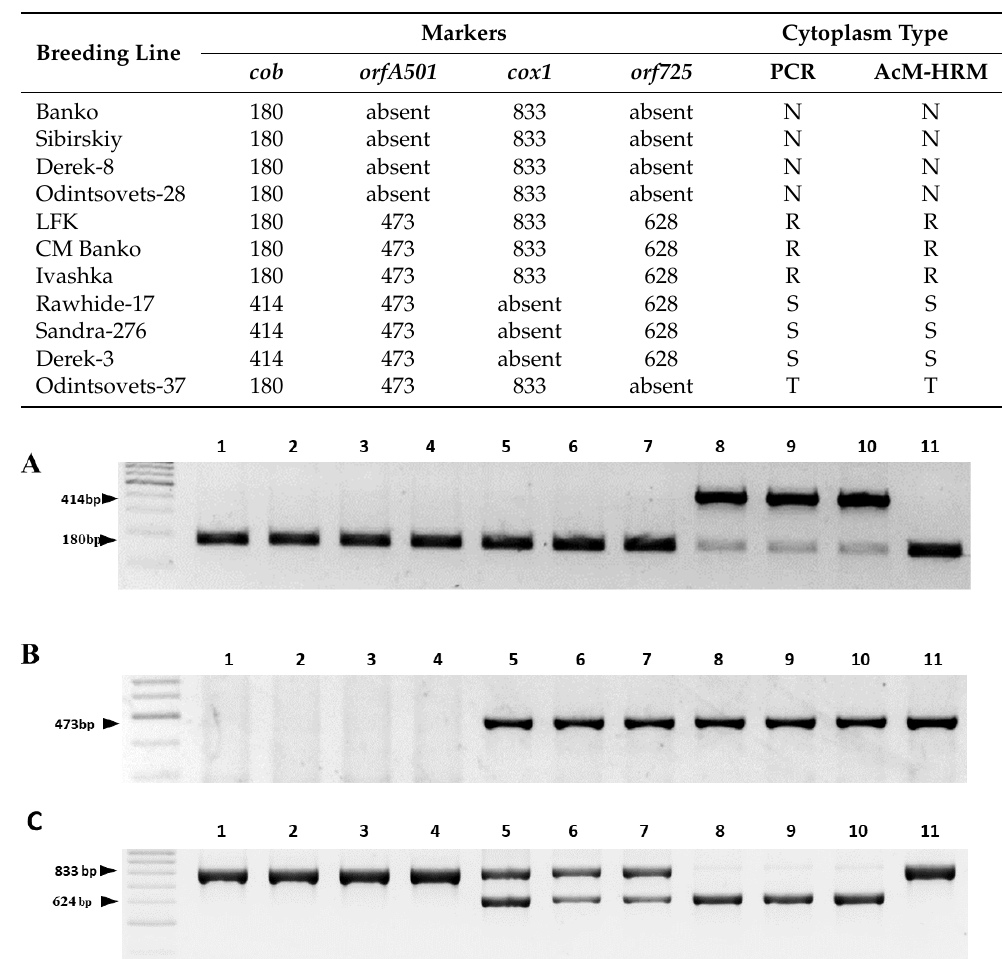
Table 2. Comparative analysis of eleven breeding lines using conventional PCR and HRM analysis. Breeding Line